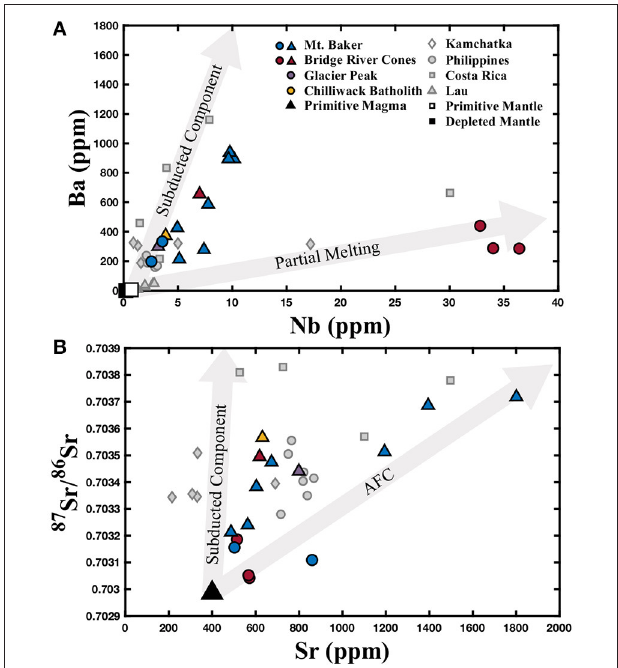
FIGURE 2 | (A) Ba and Nb contents of the North Cascades samples, as well as literature data from other volcanic arcs where available. The first labeled gray arrow approximates the effects of the addition of a subducted component (bulk sediment) prior to 10% partial melting of the depleted mantle, and the second approximates the effects of partial melting of the primitive mantle for the North Cascades based on Mullen and Weis (2013). Primitive mantle composition is from Sun and McDonough (1989). Depleted mantle composition is from Salters and Stracke (2004). (B) Sr isotope composition and Sr content of the North Cascades samples, as well as literature data from other volcanic arcs where available. The first labeled gray arrow approximates the effects of the addition of a subducted component (bulk sediment) to a primitive magma and the second approximates the effects of assimilation and fractional crystallization with a gabbro assimilant for the North Cascades based on Mullen and Weis (2013). The primitive magma composition is based on Mullen and Weis (2013). The colored circles represent those samples identified as most primitive from Mt. Baker and the Bridge River Cones, while the colored triangles represent samples that exhibit crustal contamination. North Cascades data are reported in Table 1 . Literature data are represented by gray symbols and are from Li et al.